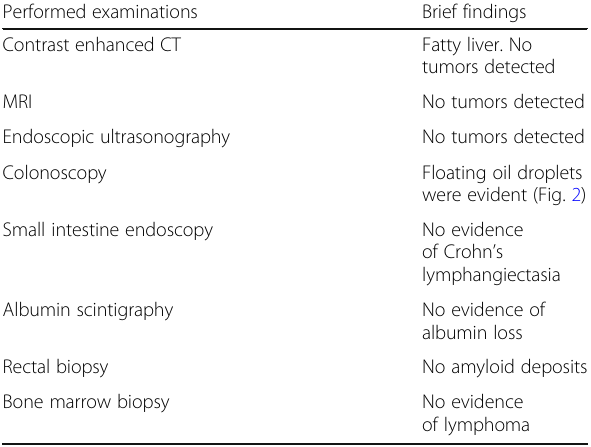
Table 2 Results of core examinations performed Performed examinations Brief